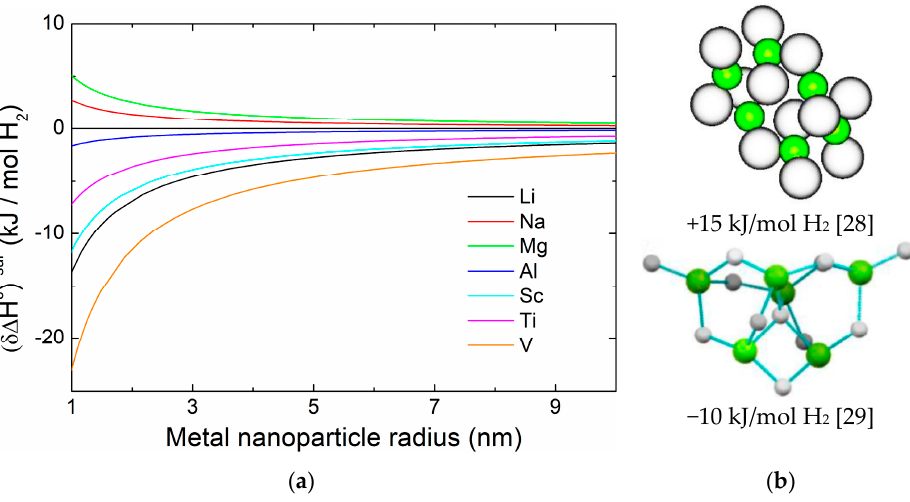
Figure 1. ( a ) Variation of the hydride formation enthalpy as a function of the nanoparticle (NP) radius (>1 nm) relative to the respective bulk materials. The curves are drawn using the parameters calculated in [27]. As a reference, remind that a NP with r = 1 nm contains about 200 Mg atoms; ( b ) Atomic structures of (MgH 2 ) 6 clusters and corresponding (δ∆H (cid:2868) ) (cid:3046)(cid:3048)(cid:3045) values calculated by DFT, taken from Refs. [28] (top, B97 functional) and [29] (bottom, LDA functional), showing strong discrepancies among different authors. The green spheres represent Mg and the white spheres H. In both ( a ) and ( b ), positive (δ∆H (cid:2868) ) (cid:3046)(cid:3048)(cid:3045) values imply that the nano-hydride is less stable than the bulk hydride.